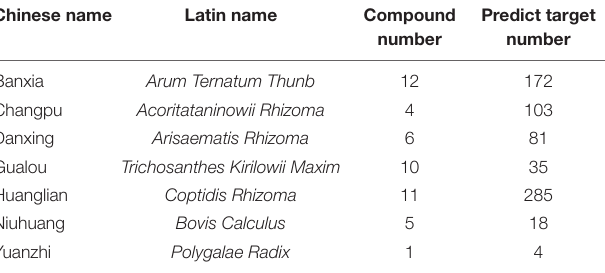
TABLE 1 | Information of ingredients in Xingnao Kaiqiao Pill and their putative targets.